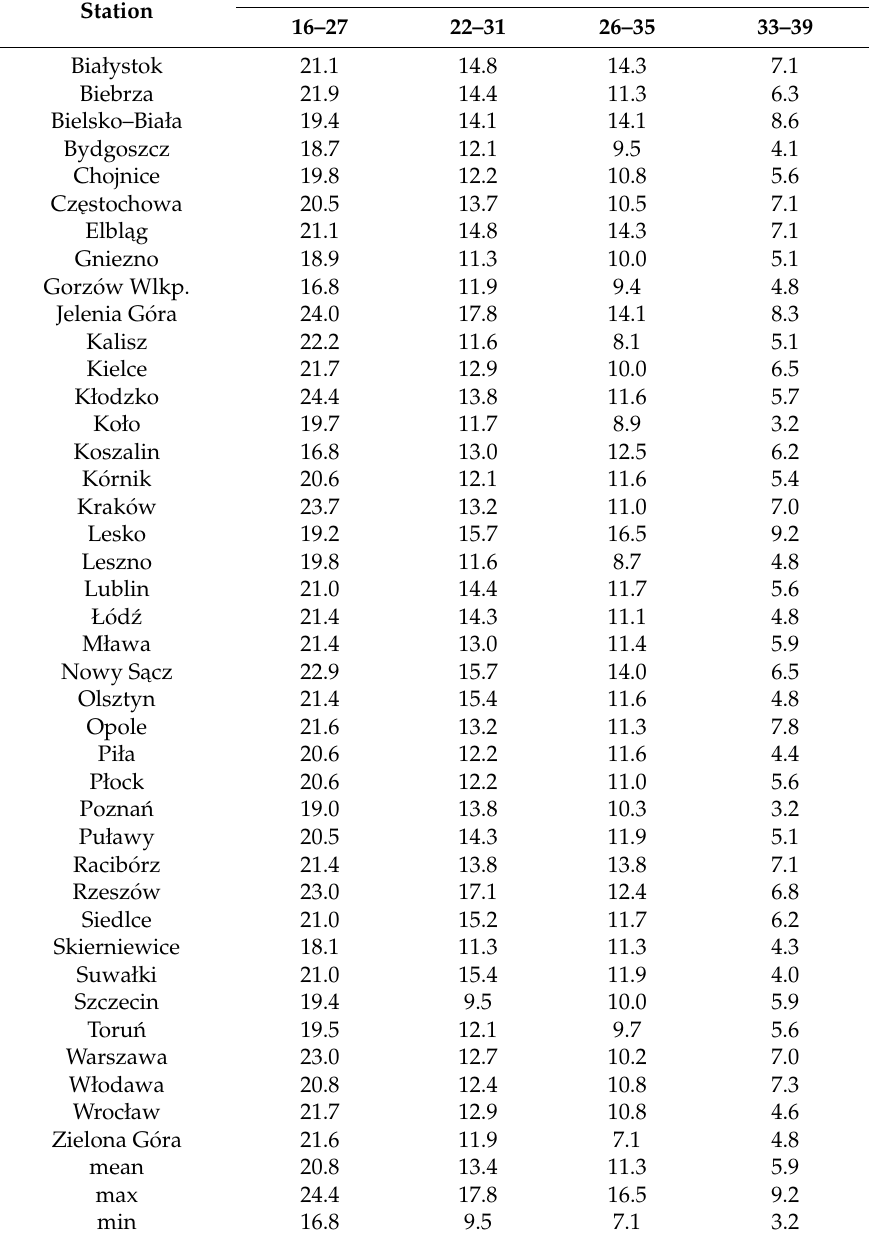
Table 4. Relative frequency of critical precipitation for the soil profile 0–100 cm.